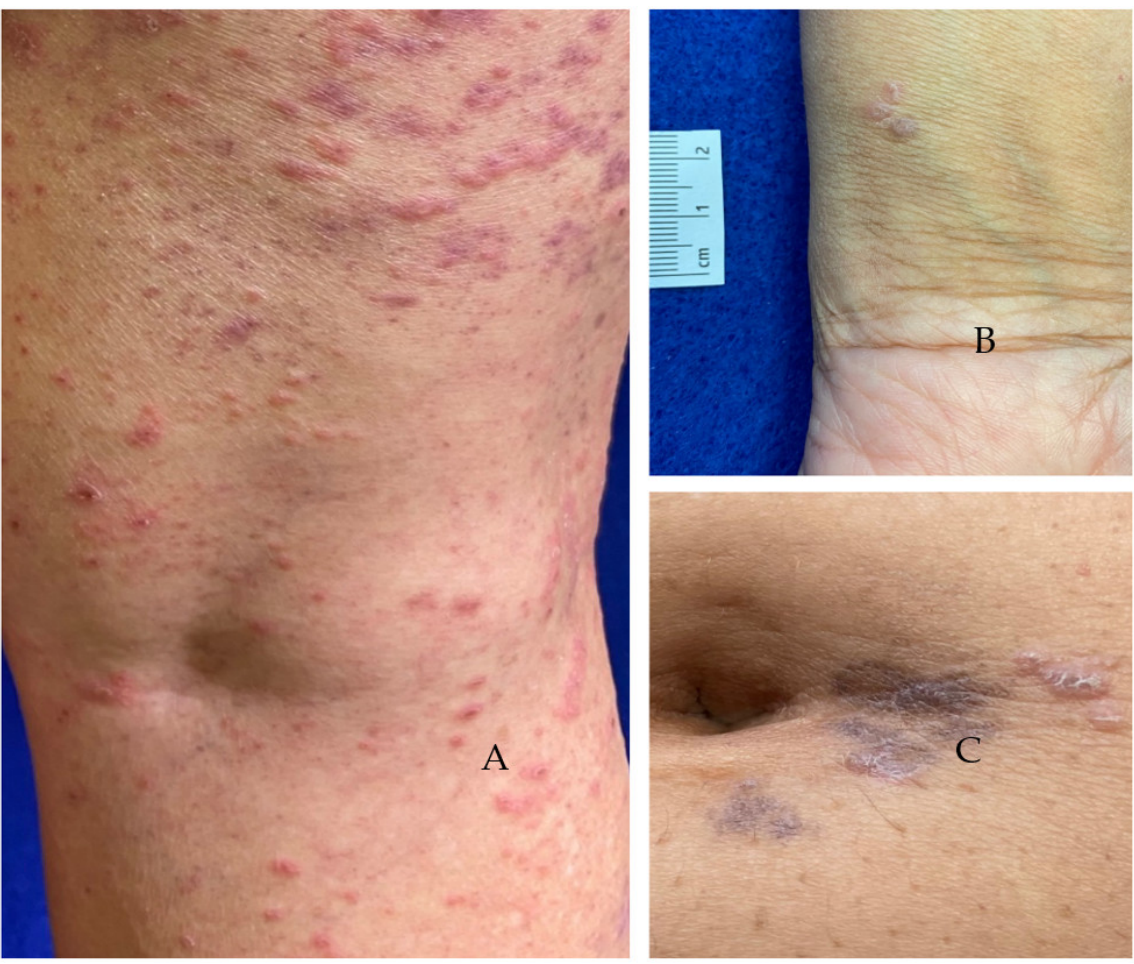
Figure 10. V-ILE. ( A ) , Case 7, 81-year-old male and ( B , C ) Case 8, 62-year-old female. ( A ) Numerous violaceous papules and plaques on the posterior aspect of the thigh and proximal leg. ( B ) Violaceous flat-topped papules clustered at the flexural aspect of the left wrist. ( C ) Violaceous papules and plaques in the periumbilical area of the abdomen respecting the midline. Wickham’s striae are evident.